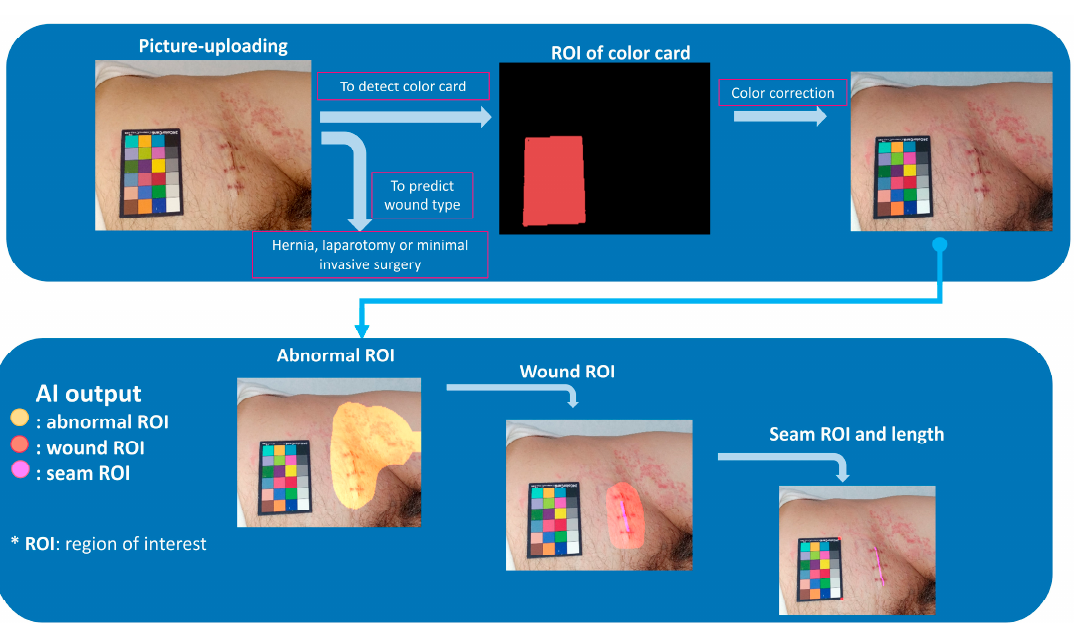
Figure 4. Step-by-step illustration of the automatic process and output of our model: prediction of wound type, identification of color card, color correction, and detection of abnormal region of interest (ROI), wound ROI, and seam